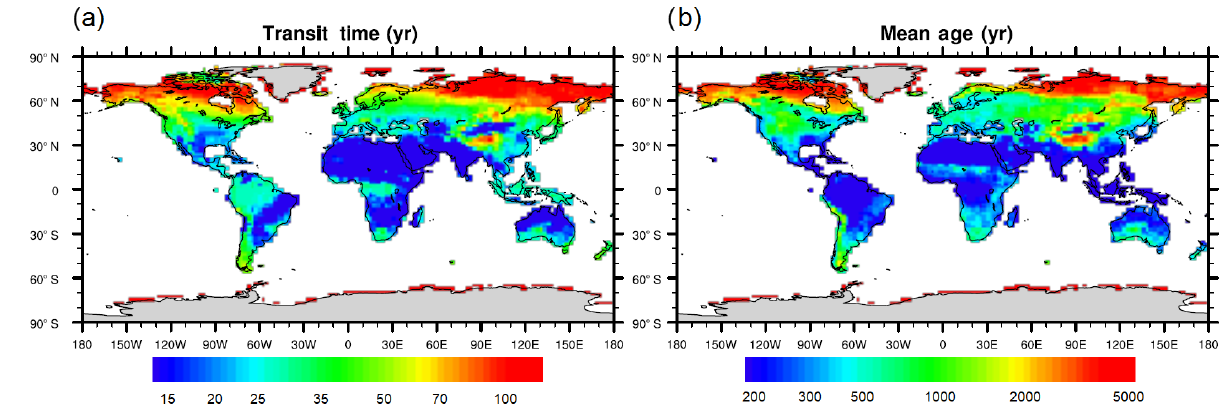
Figure 1. Global maps of (a) carbon transit time and (b) mean carbon age are the average over 1901 to 1910 in each grid cell.